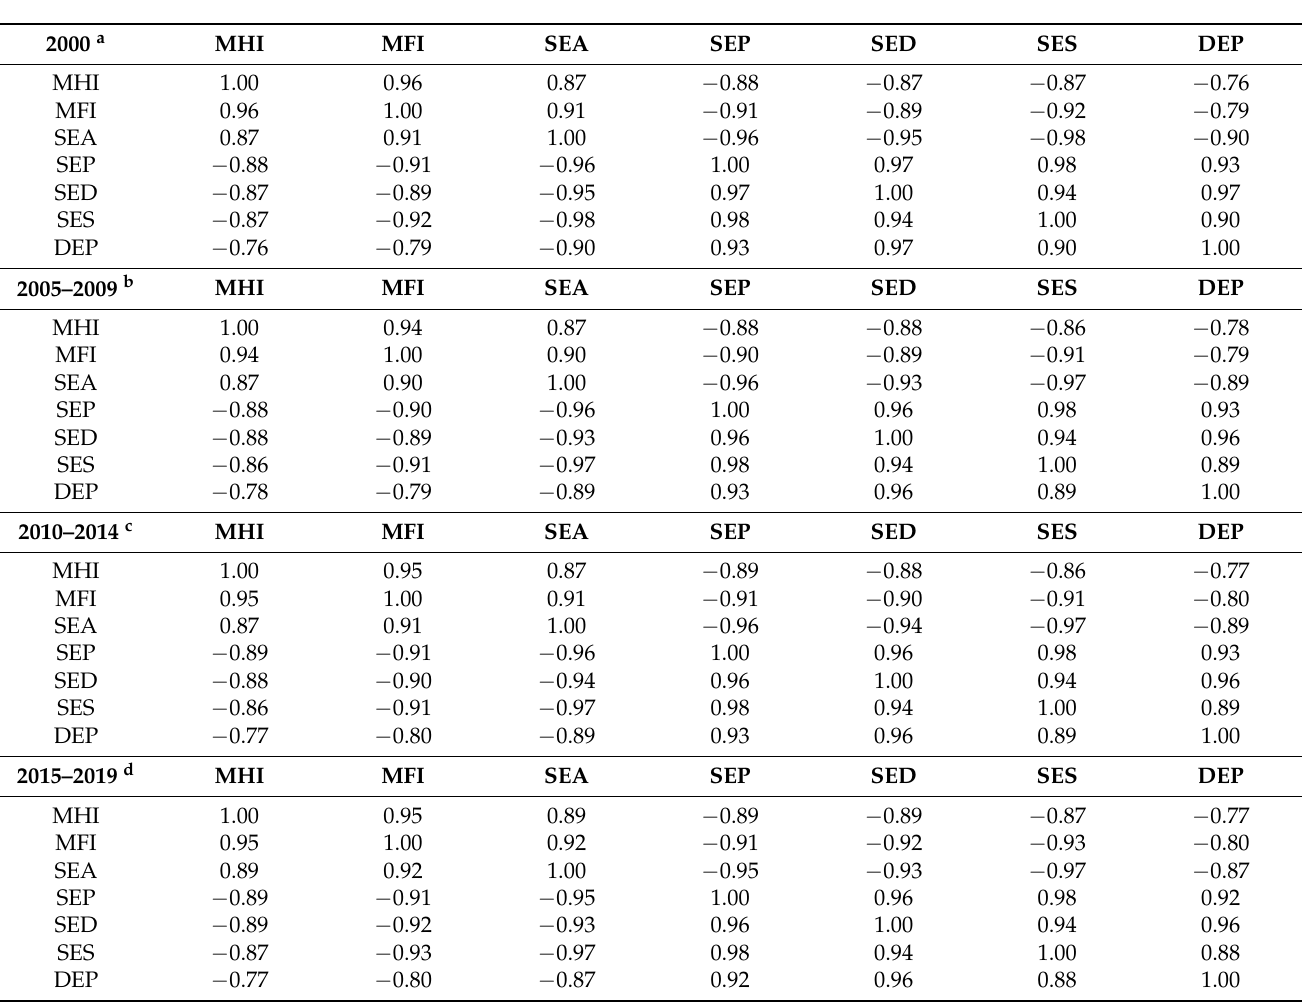
Table 3. Relationships between simple and composite measures of neighborhood socioeconomic status in the State of